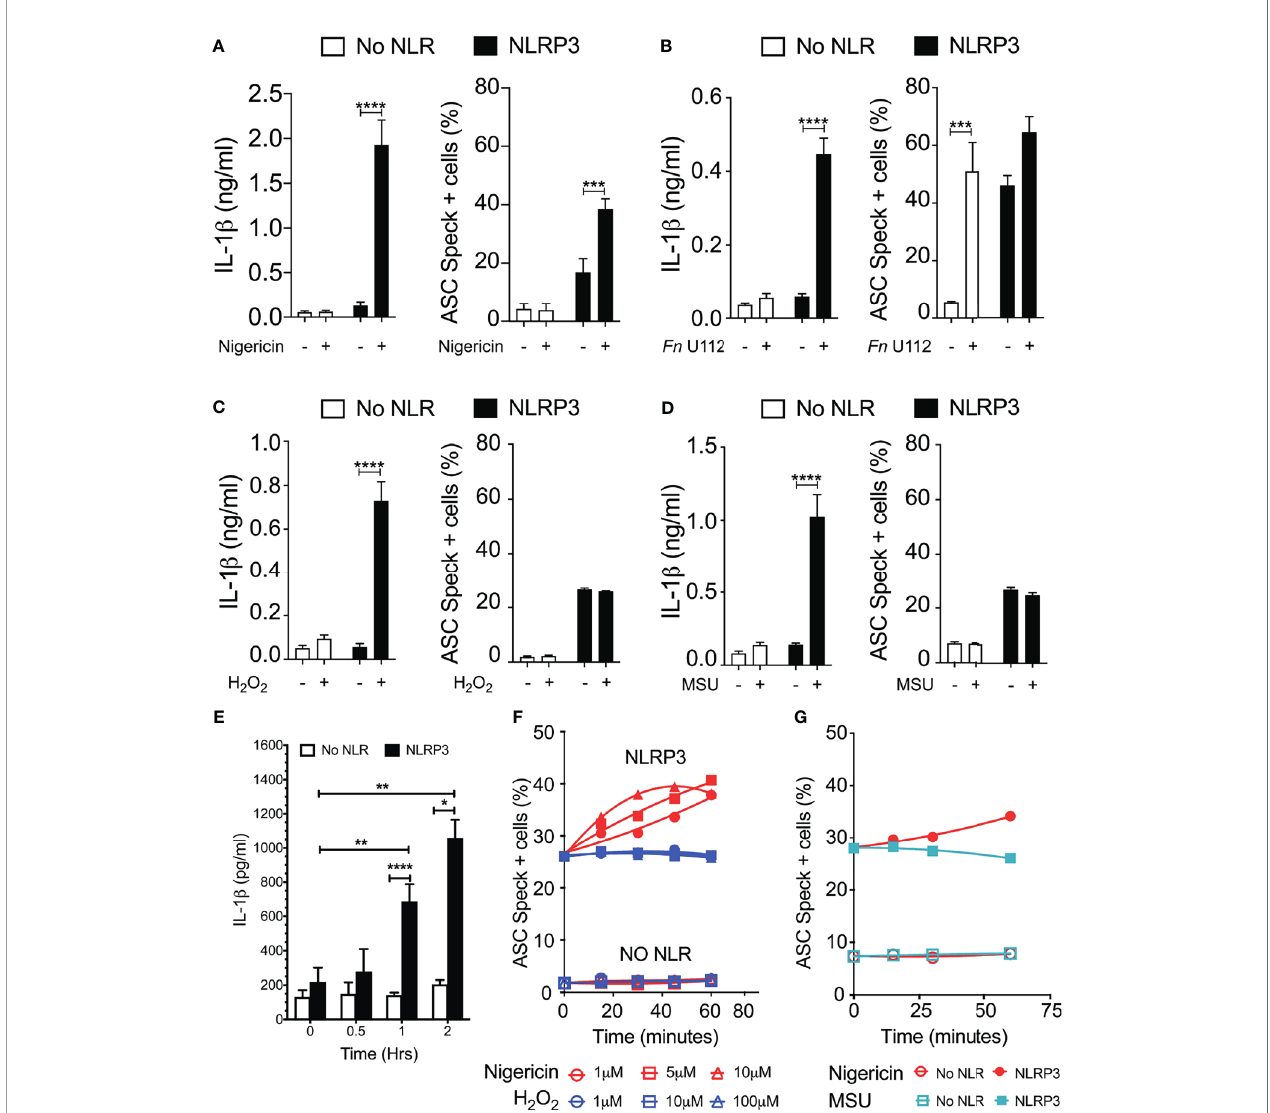
FIGURE 4 | Monosodium urate (MSU) and H 2 O 2 elicit IL-1 b without inducing ASC speck formation. Cells were transfected and stimulated for NLRP3 activation as described in the Methods: In fl ammasome Activation . (A) IL-1 b processing and speck formation exhibits positive correlation in nigericin-stimulated cells. (B) Unlike speck formation, IL-1 b processing is dependent on NLRP3 in F novicida U112-infected cells. (C) IL-1 b and speck formation shows no correlation in H 2 O 2 -treated cells. H 2 O 2 -treated cells do not induce speck formation. (D) IL-1 b and speck formation shows no correlation in MSU-treated cells. MSU-treated cells do not induce speck formation. (E) Time-course analysis of H 2 O 2 -treated IL-1 b processing in in fl ammasome-reconstituted HEK293T cells. (F) Cells were treated with 5 µm nigericin (red) or 100 µM H 2 O 2 (blue) for 1 h and analyzed for ASC speck+ cells by TOFIE. (G) Cells were treated with either 5 µm nigericin (red) or 150 µg/ml MSU (cyan) for 1 h and analyzed for ASC speck+ cells by TOFIE. Data represented as mean ± SEM for a minimum of three independent experiments (A – E) . Data represented as mean ± SEM for two independent experiments (F, G) . * p < 0.05, ** p < 0.01, *** p < 0.001, **** p < 0.0001 for comparison with respective untreated; two-way ANOVA followed by Sidak ’ s multiple comparison